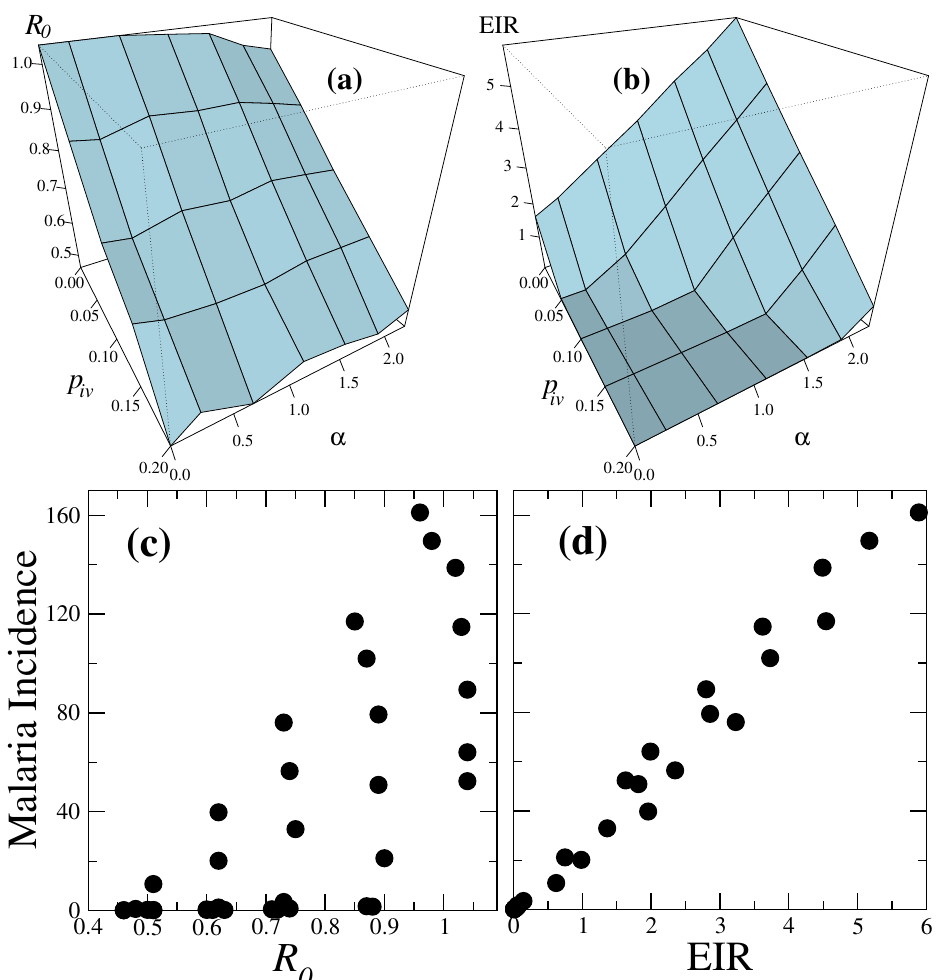
Figure 8. ( a ) The basic reproduction number, Equation (2), and ( b ) the annual entomological inoculation rate, Equation (7), both as a function of the ivermectin probability p iv and heterogeneous affinity α . In ( c , d ), we show the scatter-plots of the basic reproduction number and annual entomological inoculation rate, respectively, with the corresponding values of malaria incidence. Clearly, there is a significantly stronger correlation of malaria incidence with EIR than with R 0